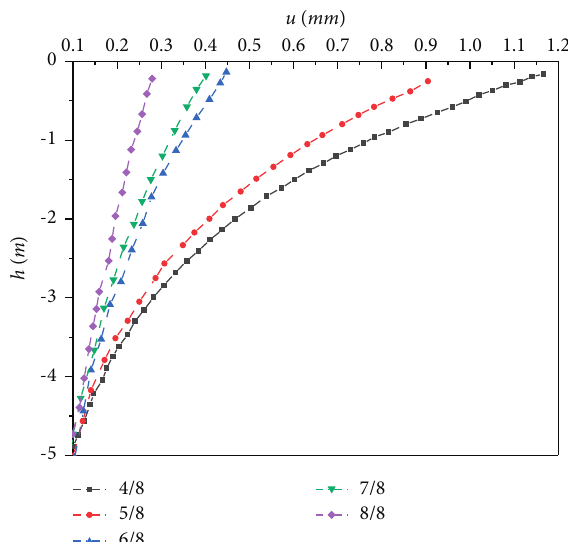
Figure 25: Displacement comparison at different